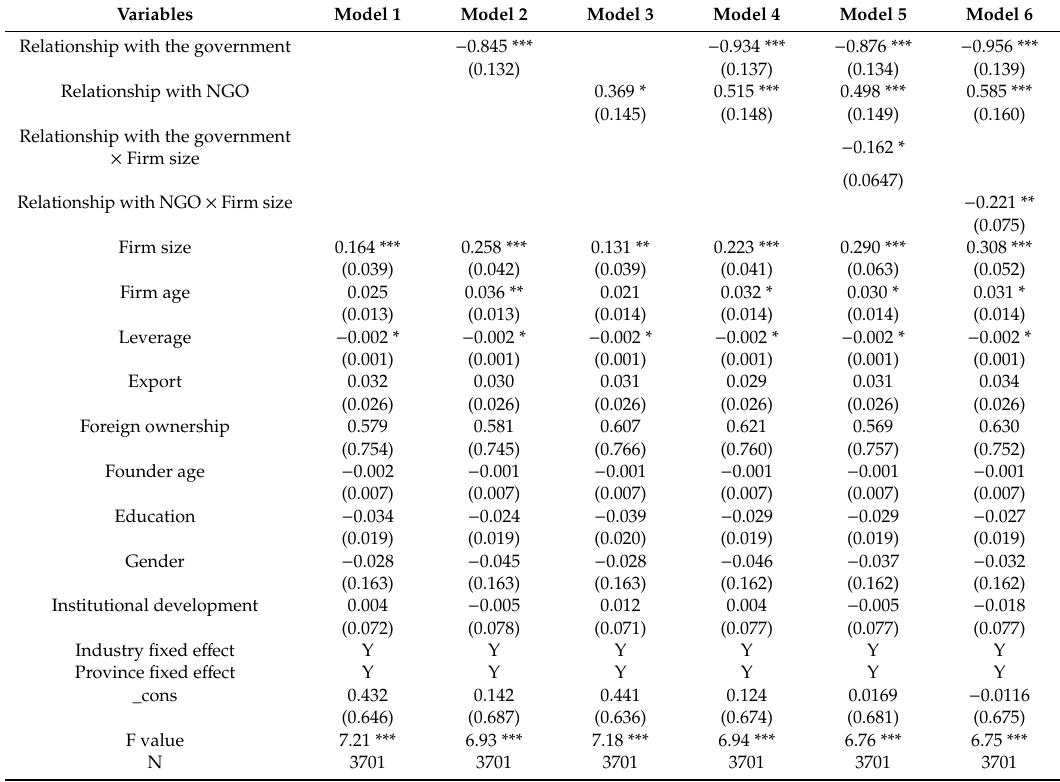
Table 2. Regression models for firm eco-e ffi